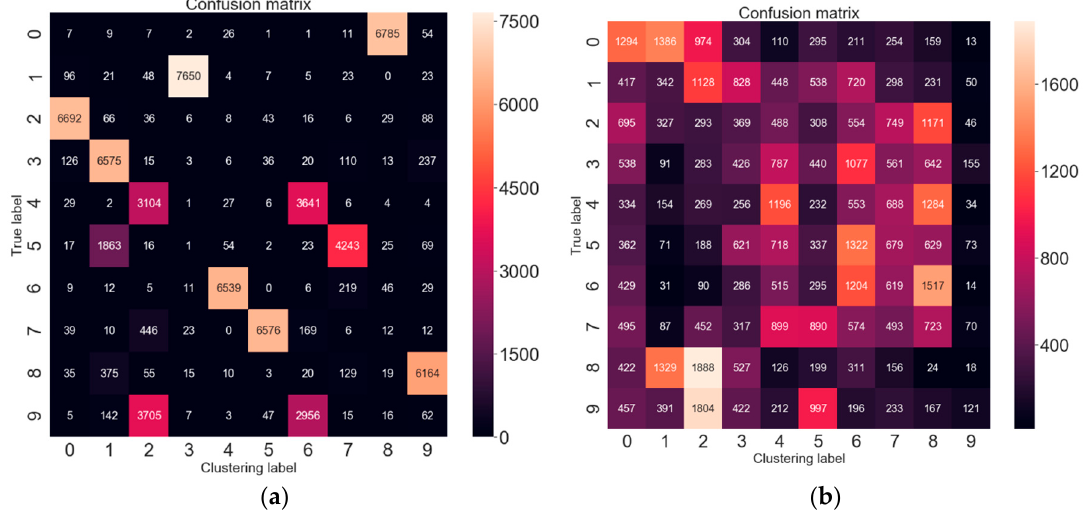
Figure 6. ( a ) Confusion matrix of MNIST; ( b ) Confusion matrix of CIFAR-10.